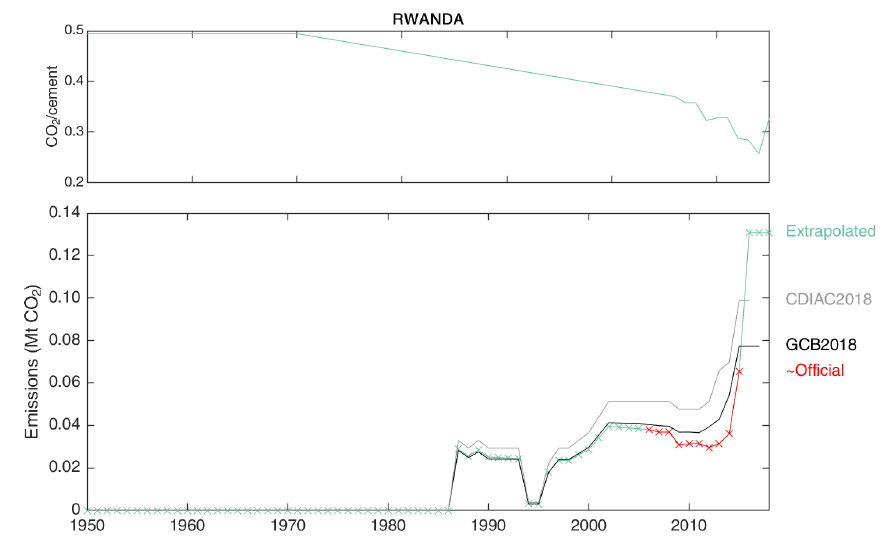
Figure C36. Revised cement emissions for